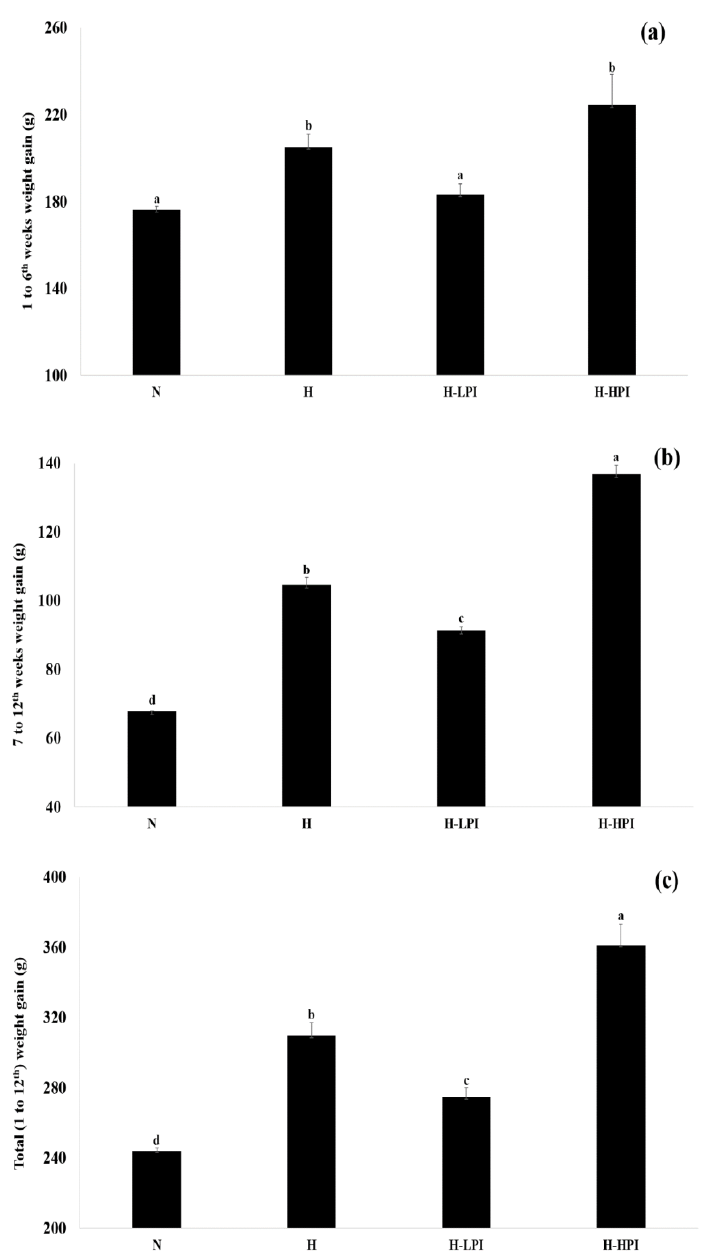
Figure 2. Comparisons of body weight gains between groups (1~12th weeks). ( a ) Weight gain during the period from 1 to 6th weeks, ( b ) weight gain during the period from 7 to 12th weeks, and ( c ) total weight gain during the periods from 1 to 12th weeks. Mean with different letters (a–d) corresponds the significant difference determined through the non-parametric Friedman test followed by Dunn’s test ( p < 0.05).